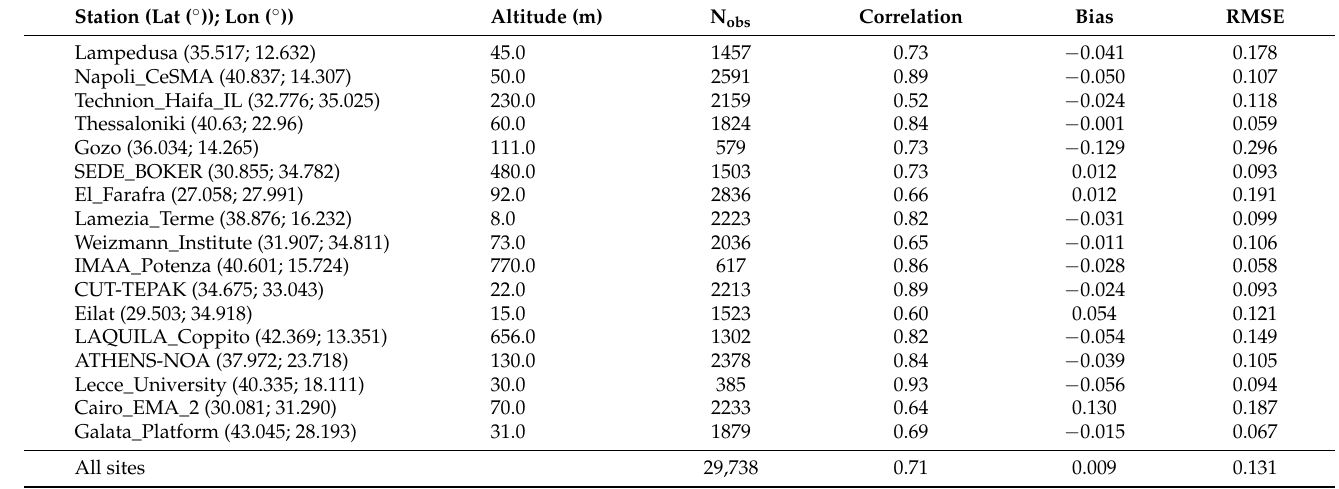
Table 2. Scores in terms of correlation, bias and RMSE between the AERONET in situ measurements and the MODIS AOD assimilation over the stations shown in Figure 6.